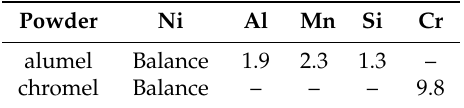
Table 1. Elemental composition of powders (by weight, wt %).